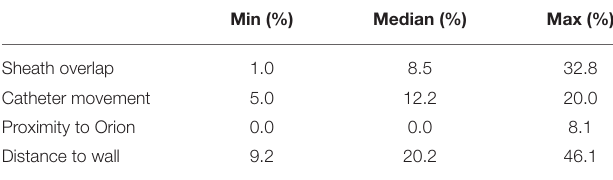
TABLE 1 | Exclusion of LI